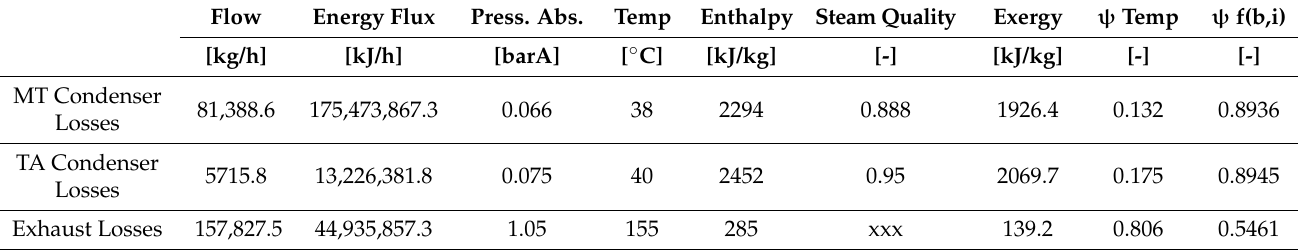
The calculated factors of the energy quality (i.e., exergy ψ = f(b, i) and temperature ψ = f(T)) sources of exhaust gas highlight their sufficient energy level to be usefully